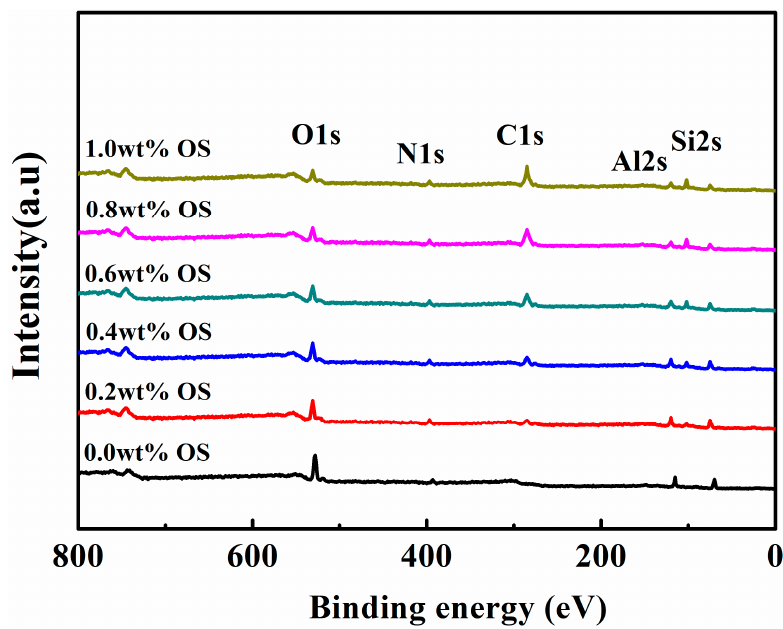
Figure 3. XPS spectra of various OS-modified AlN powder. Table 3. Surface elements abundance of various OS-modi fi ed AlN powder based on XPS.